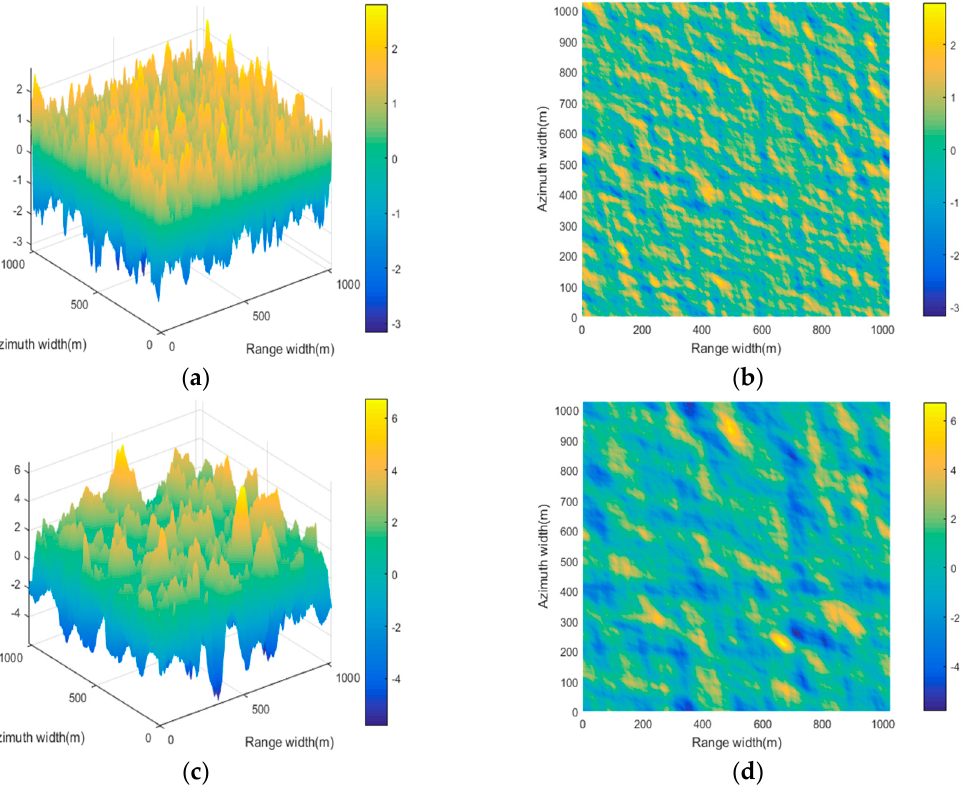
Figure 3. 2D ocean surface diagram as follows: ( a ) 2D sea surface at a wind speed of 10 m/s, ( b ) top view of ( a ), ( c ) 2D sea surface at a wind speed of 15 m/s, and ( d ) top view of ( c ). The color bars on the right side of the figure represent the height fluctuations of the ocean surface.